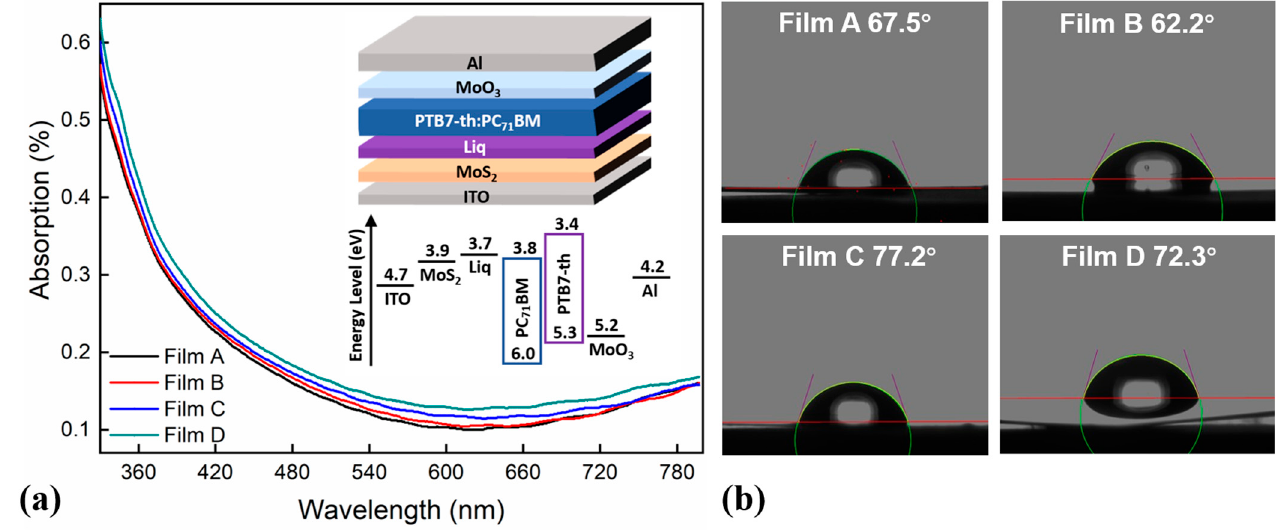
Figure 1. ( a ) Absorbance properties of Films A, B, C, and D; inset is the structure and energy level of Device D. ( b ) The water contact angles of Films A, B, C, and D.